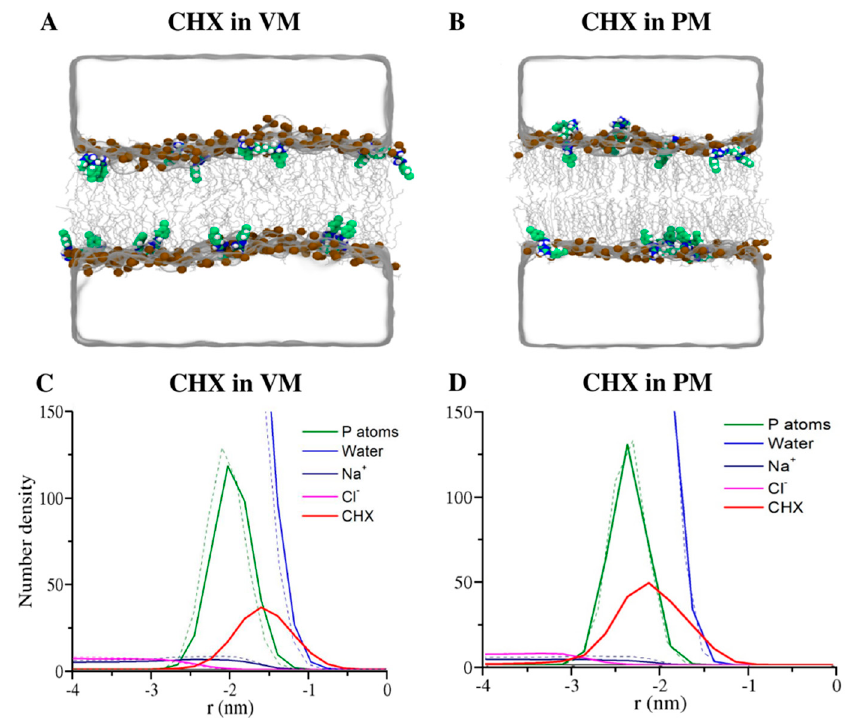
Figure 2. ( A , B ) MD simulation snapshots of CHX binding to VM/PM. Upper and lower leaflets of the membrane are represented by lipid phosphorus atoms, which are rendered as brown spheres, lipid tails are shown as gray lines, and water is shown as a transparent surface. Ions are not shown for clarity. ( C , D ) Atomic density profiles. The dotted lines represent membrane-only systems, and solid lines represent CHX-containing membranes.